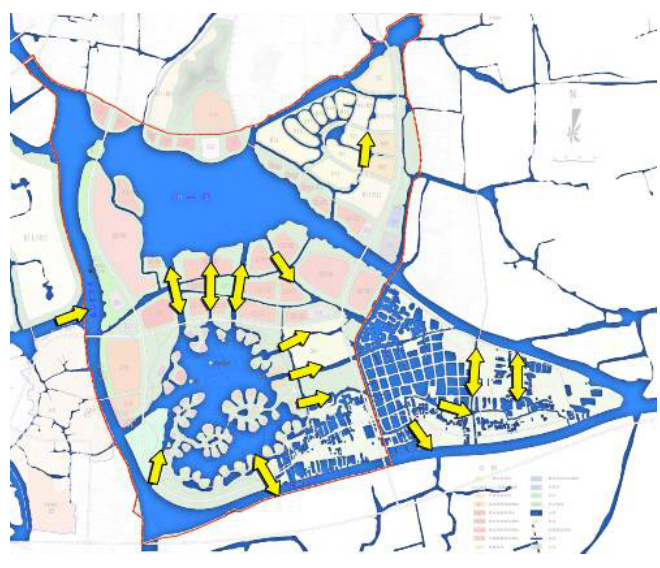
Figure 5. Flow directions of the inner river network in a